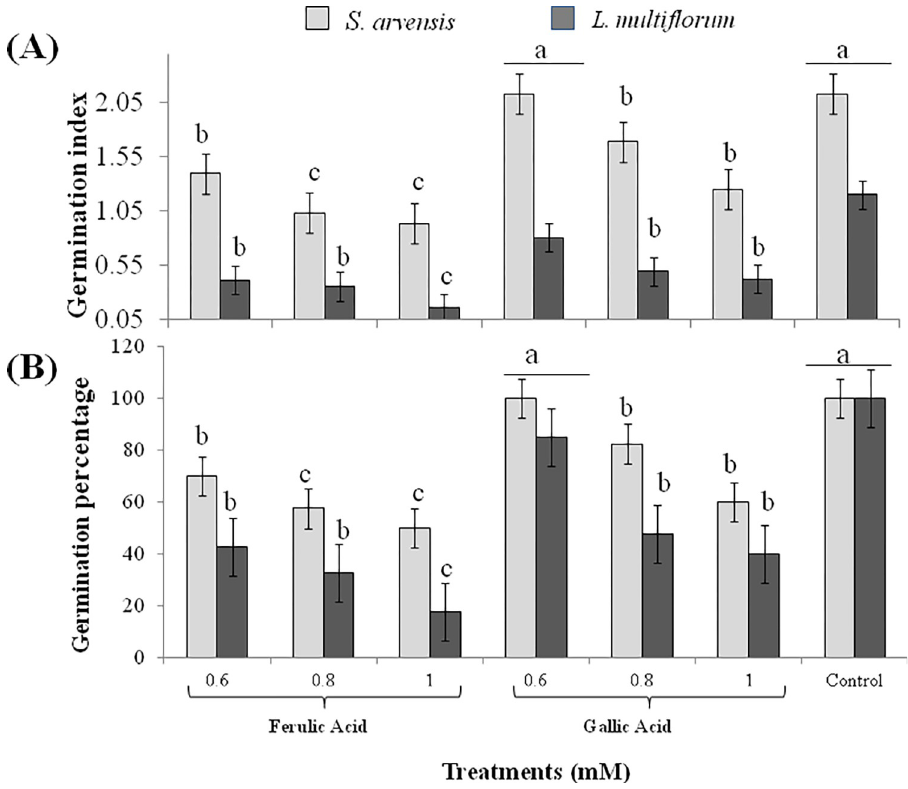
Fig 1. Growth response of Sinapis arvensis and Lolium multiflorum to 0.6, 0.8 and 1 mM ferulic acid (FA) and gallic acid (GA) and aqueous control. (A) Germination index and (B) germination percentage. Data are presented as mean ± SE (n = 10). Bar values with different letters differ significantly at P <